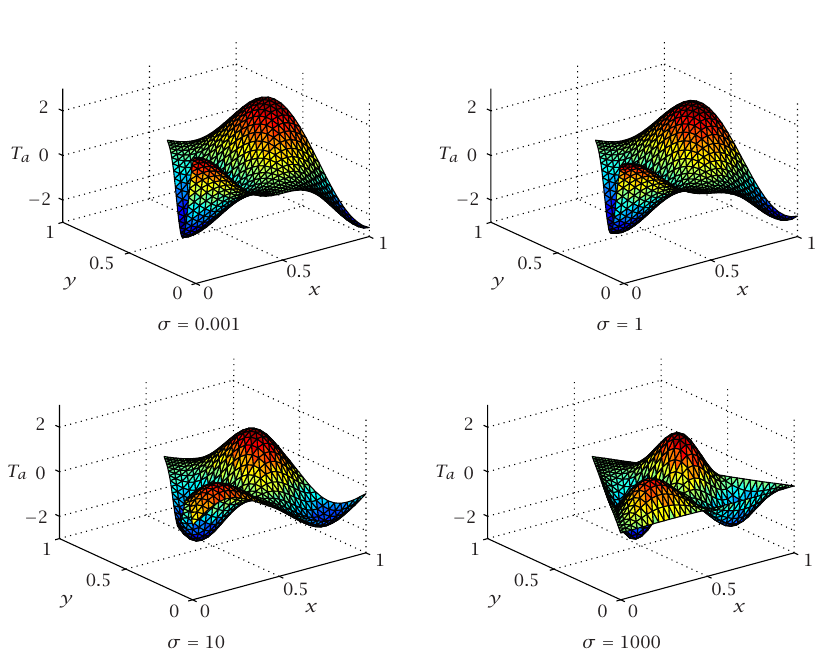
Figure 7.3 . The ( 0 , 2 ) antisymmetric